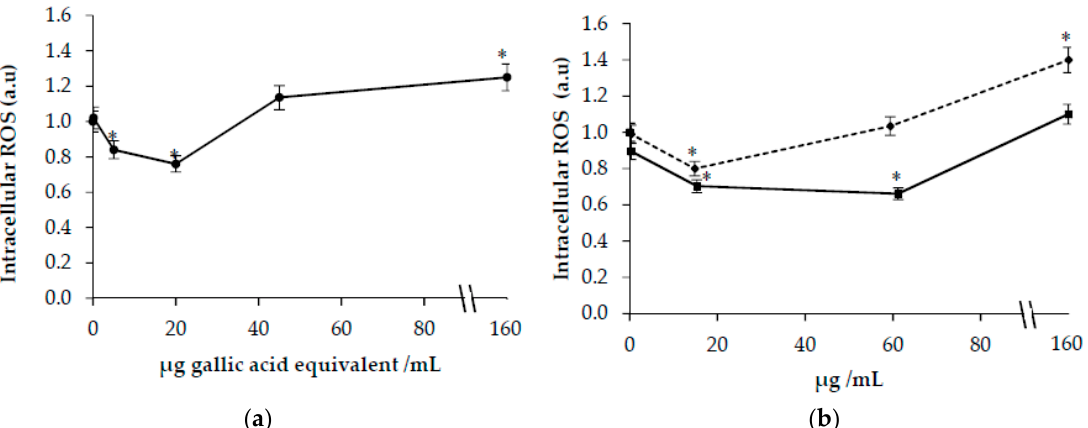
Figure 3. Intracellular reactive oxygen species (ROS) formation in HuDe cells treated for 48 h in the presence of increasing concentrations of Carthamus Tinctorius (CT) extract (a) or hydroxy safflor yellow A (HSYA) ( ) and safflor yellow A (SYA) ( ) (b). Phenolic concentrations of CT extract are expressed as μ g gallic acid equivalent/mL. * p < 0.05 vs. cells incubated in the absence of CT extracts or SYA and HSYA.